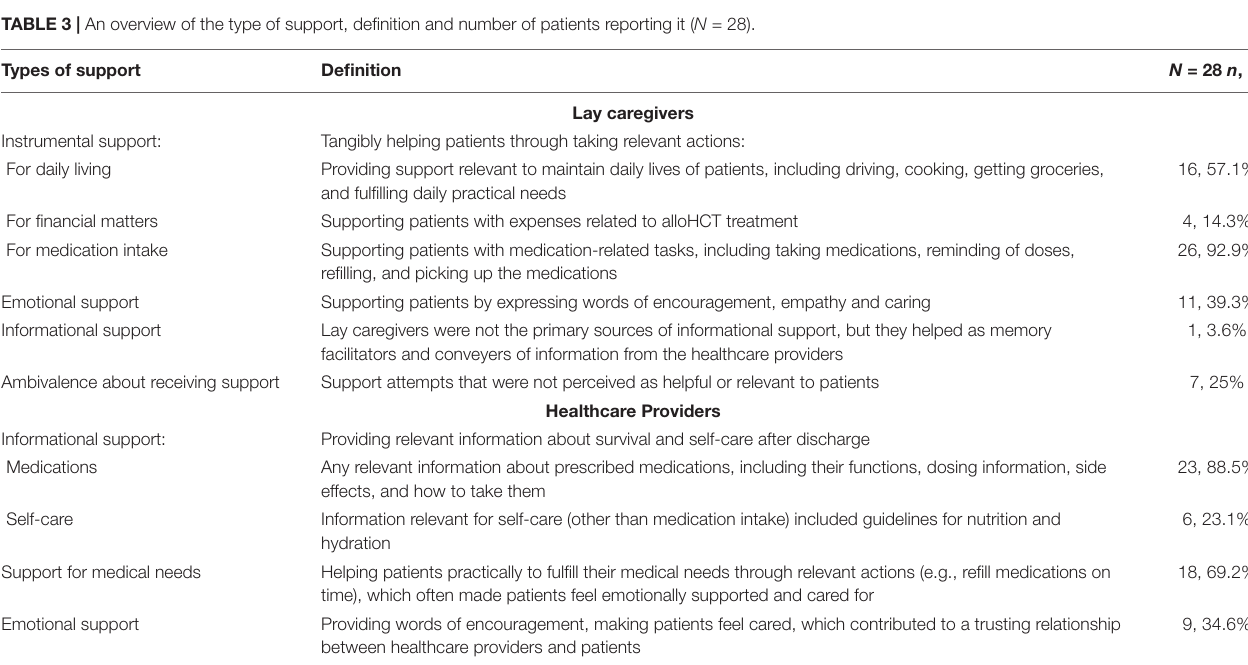
FIGURE 1 | Primary support providers individuals after transplant ( n = 28).